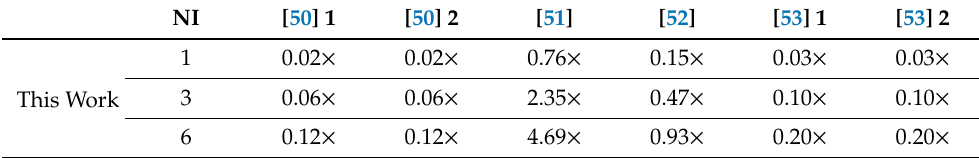
Table 15. Analysis of the ratio occupation for NR.